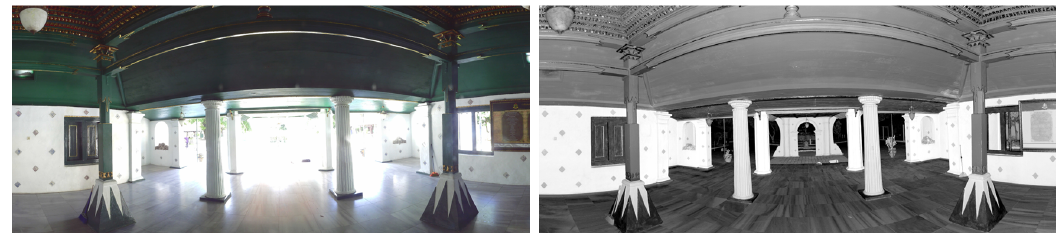
Figure 3. Example of a section of a panoramic image captured by the TLS. The figure to the left shows the RGB image, with strong overexposure due to sunray intensity. The figure to the right shows the intensity image, which was preferred in the tie point identification